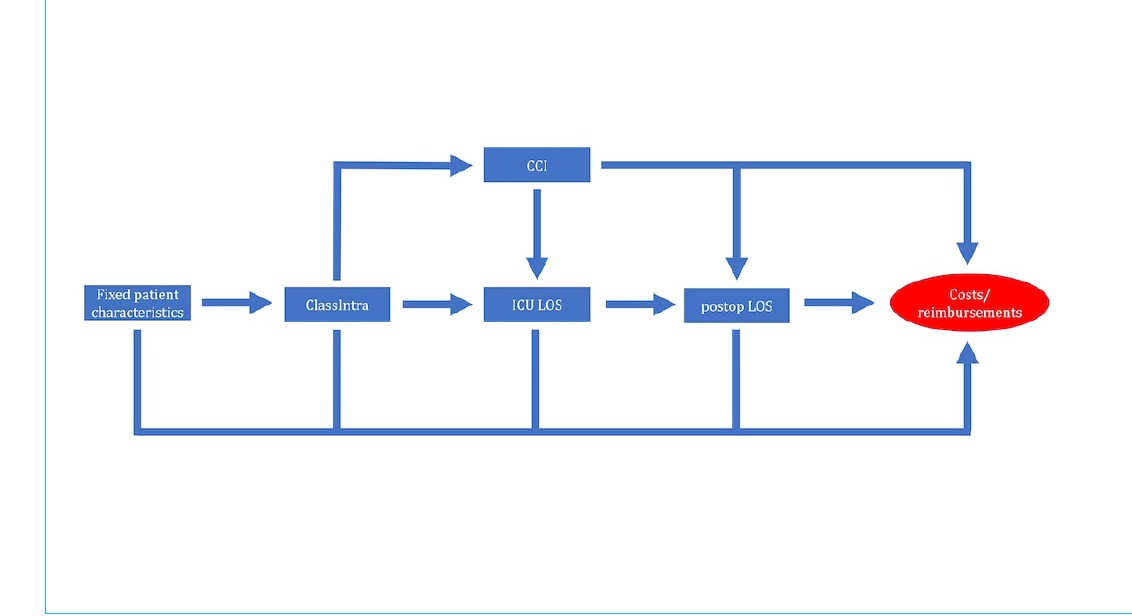
Figure 2: Path diagram for the relationship of cost-driving factors. This diagram reflects how potential cost-driving factors were included in the structural equation models. CCI: comprehensive complication index; LOS: length of